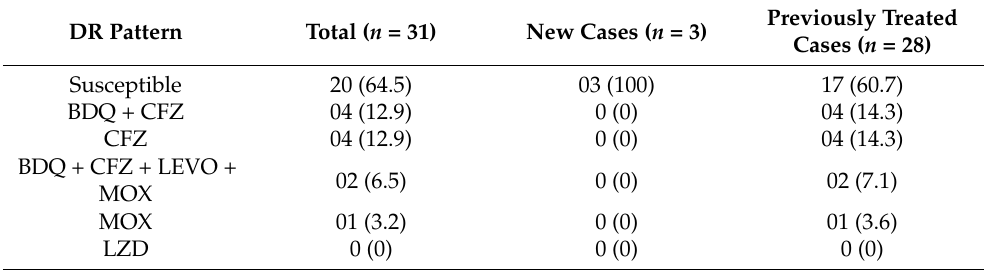
Table 5. Second-line drug-resistant patterns among new and previously treated cases (N =